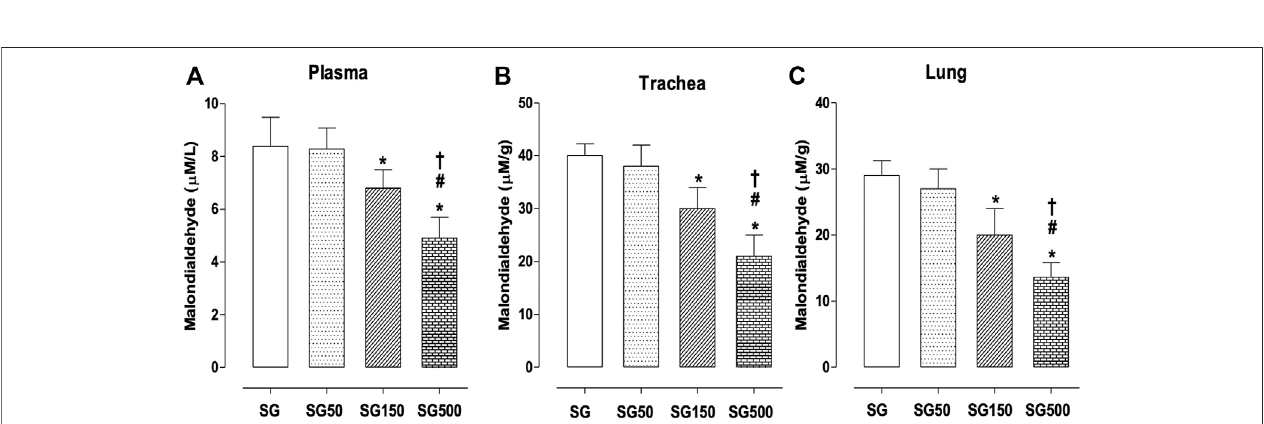
FIGURE 5 | Lipid peroxidation in blood plasma (A) , trachea (B) , and lung (C) from SG (fx4), SG50 (fx5), SG150 (fx6), and SG500 groups (fx7). The columns and vertical bars represent the mean and S.D., respectively (n = 10). One-way ANOVA followed by Bonferroni ’ s post-test. * p < 0.05 (SG vs . SG150 and SG500), # p < 0.05 (SG50 vs .SG150andSG500)and † p < 0.05(SG150 vs .SG500).Healthysalinegroup=SG.Healthygroupsupplementedwith S.platensis at50,150,and500 mg/kg= SG50, SG150, and SG500,